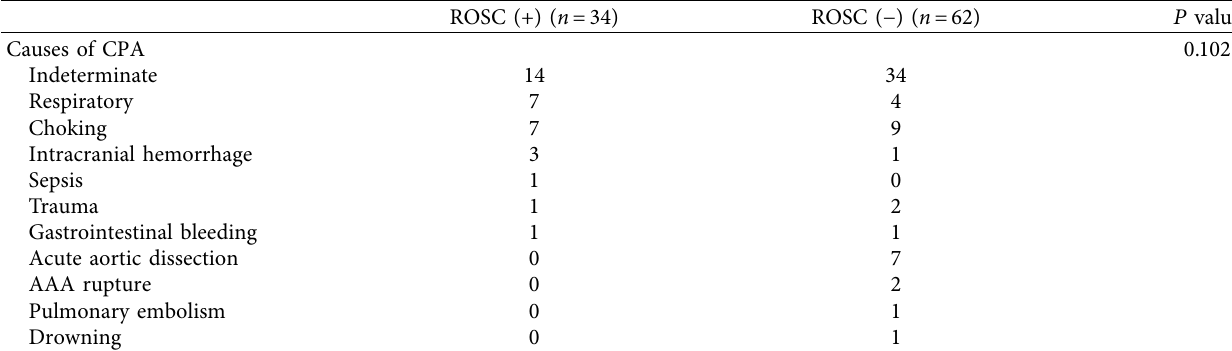
Table 2: Comparison of the causes of CPA between the two groups.